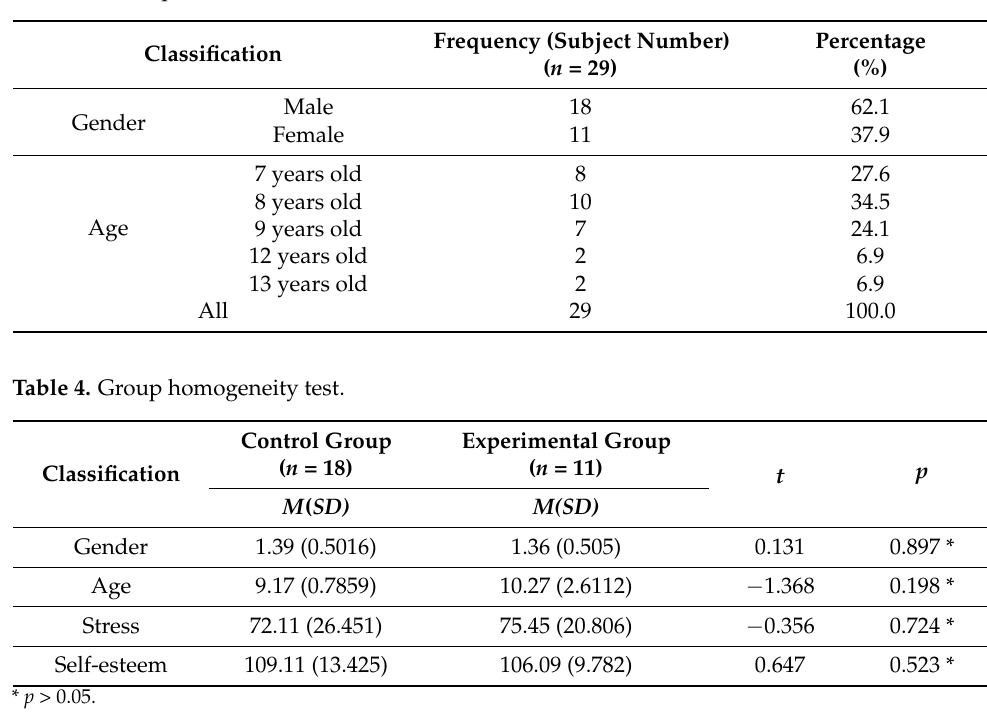
Table 3. Participants’ characteristics and work.